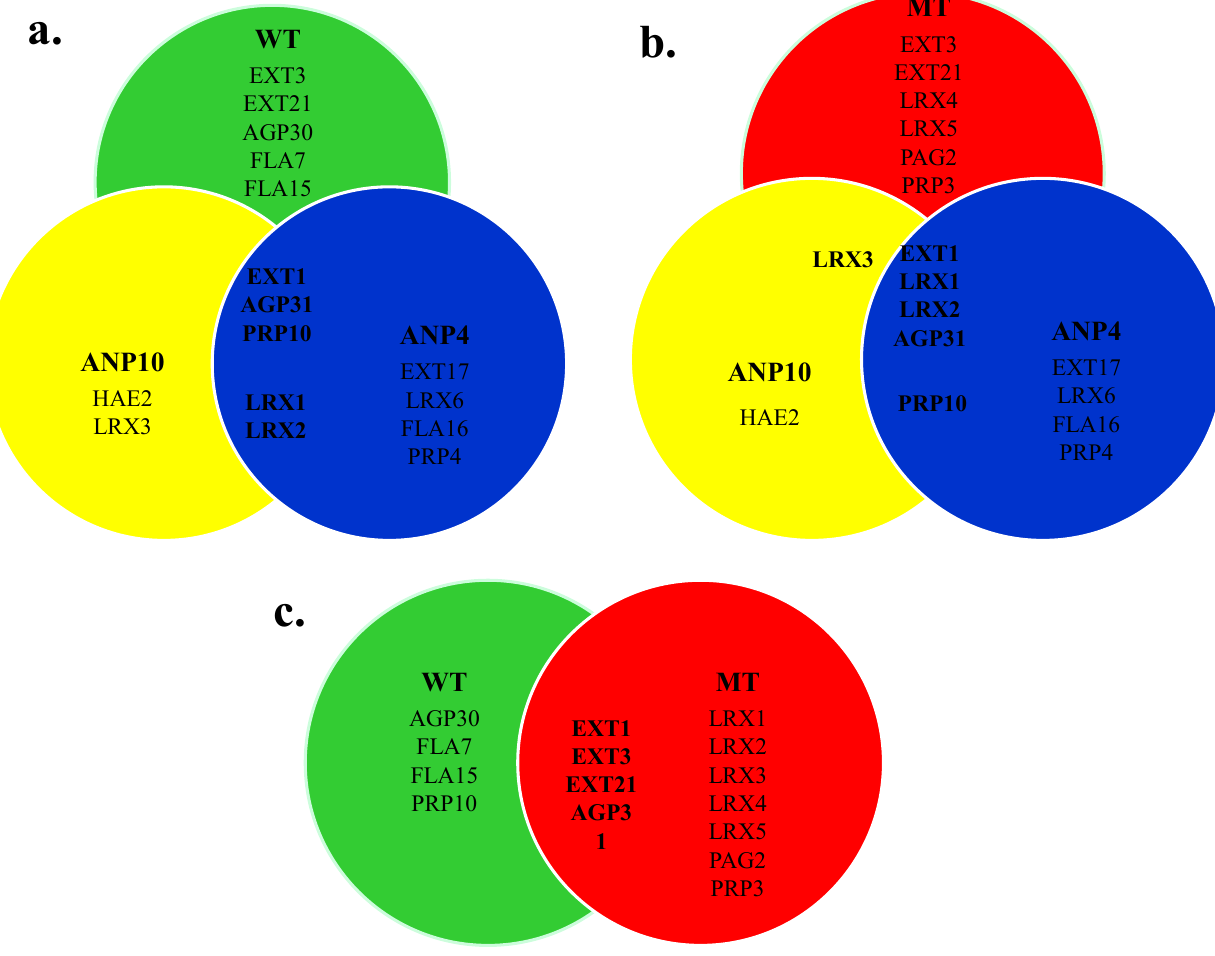
Figure 5. Comparison of members in HRGP networks of ( a ) WT and ANPs; ( b ) MT and ANPs and ( c ) WT and MT identified by proteomics